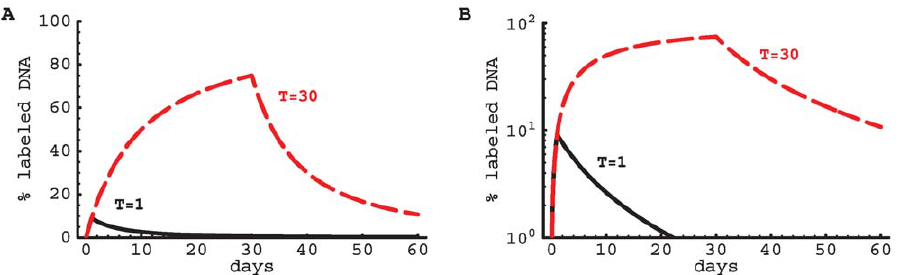
Figure 2.Model predictions for exponentially distributed turnover rates. We have plotted the changes in the fraction of labeled DNA according to the explicit kinetic heterogeneity model with exponentially distributed turnover rates (eqn. (5), mean (cid:1) dd ~ 0 : 1 = day). Predicted changes are shown for a short labeling period ( T ~ 1 day, solid line) and a long labeling period ( T ~ 30 days, dashed line) on a linear (panel A) and a logarithmic (panel B) scale. The initial uplabeling rate is independent of the length of the labeling period and is given by (cid:1) dd . The initial rate of delabeling, in contrast, depends on the length of the labeling period and is approximately twice as fast in the case of short-term labeling as compared to long-term labeling.